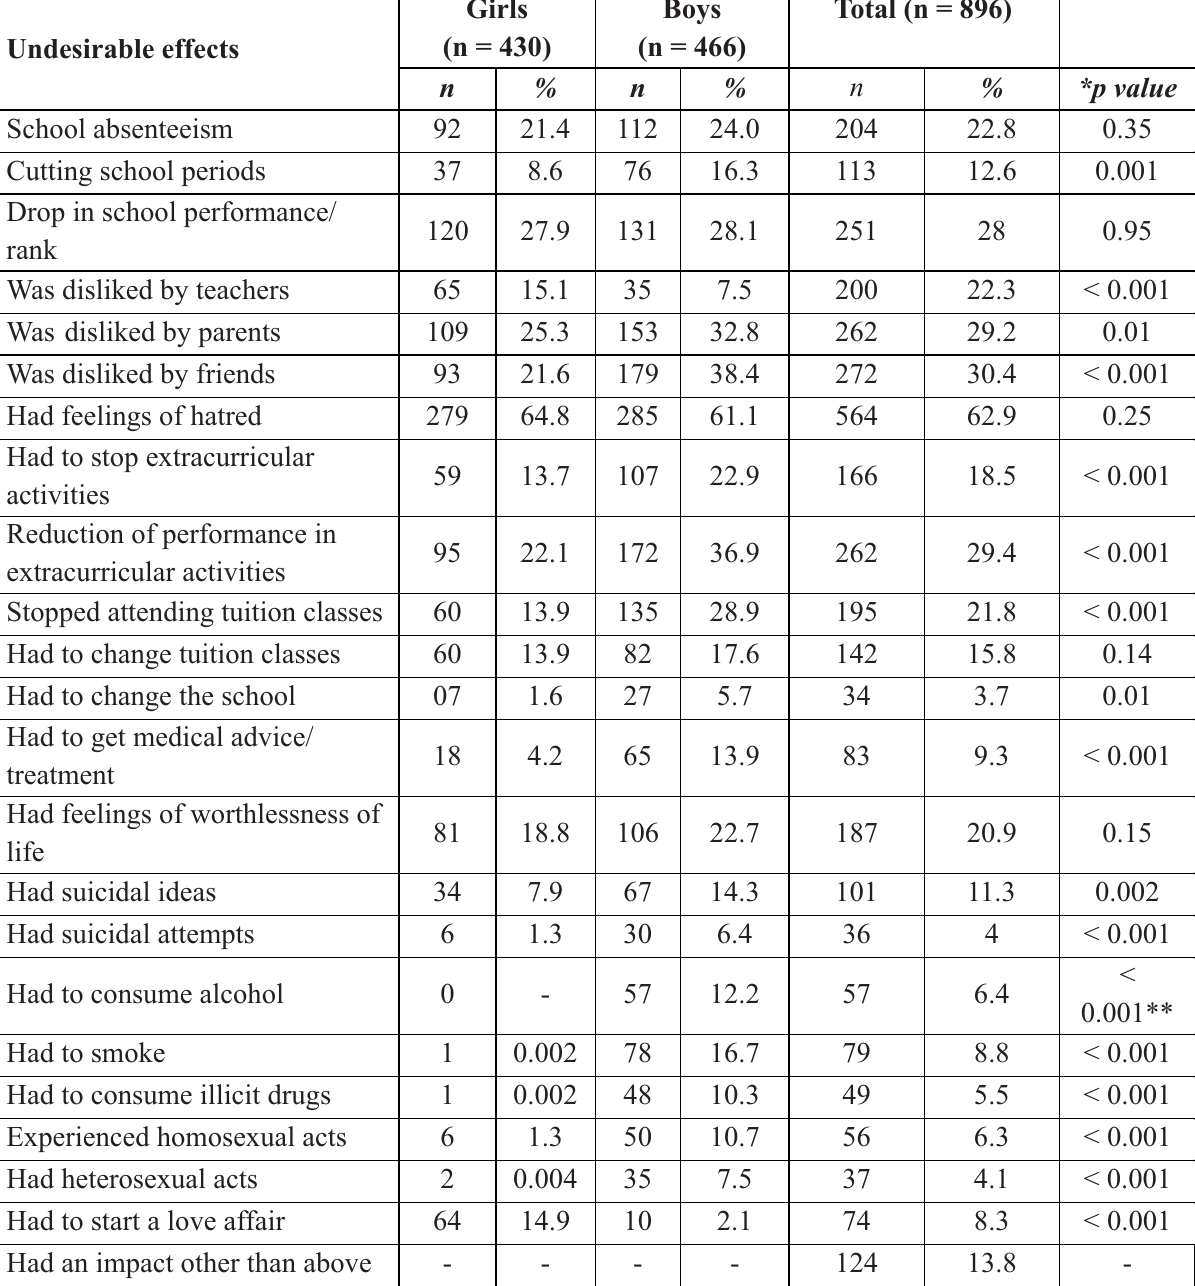
Table 4: Undesirable effects of bullying & negative peer pressure on adolescents, according to